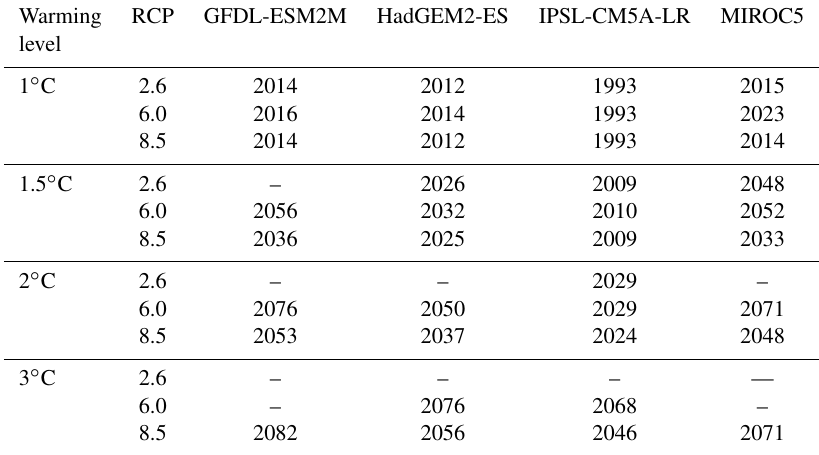
Figure 1. Conceptual representation of how GW levels are determined for different GCMs, RCPs, and the PI comparison period. Table 2. Overview of the warming levels and in which year they are reached in the corresponding GCM (ISIMIP, 2019). Warming RCP GFDL-ESM2M HadGEM2-ES IPSL-CM5A-LR